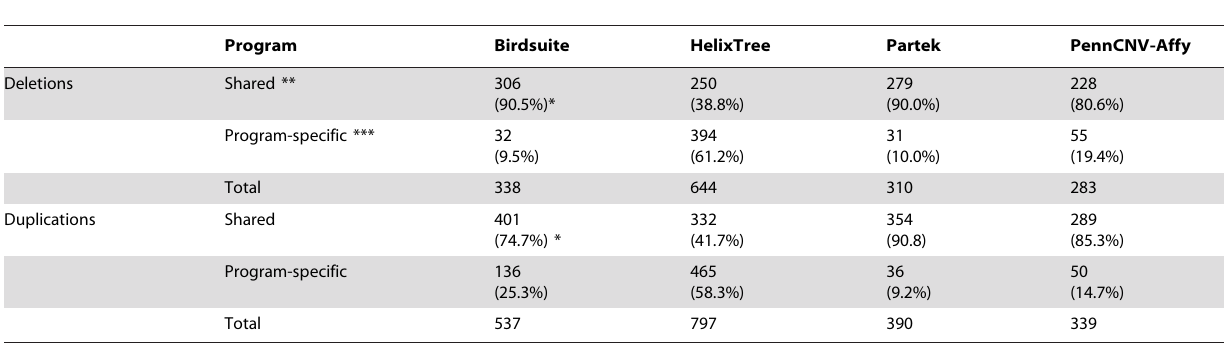
Table 5. The number of singleton CNVs called by each program, and percentage by which they overlap with calls made by the other